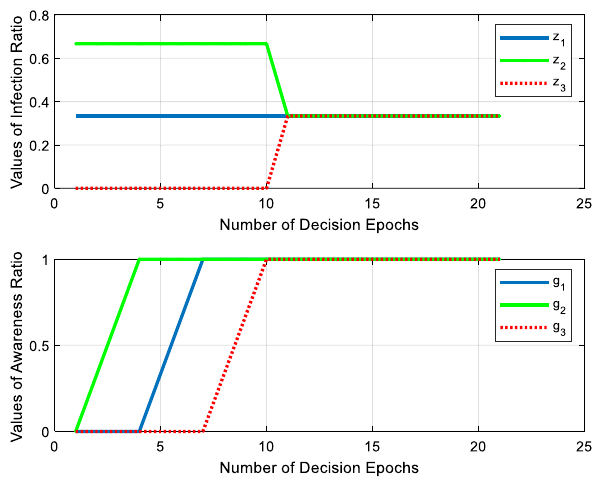
Fig. 7 Sample trajectory with optimal control policy where z i is the infection ratio for network i and g i is the corresponding